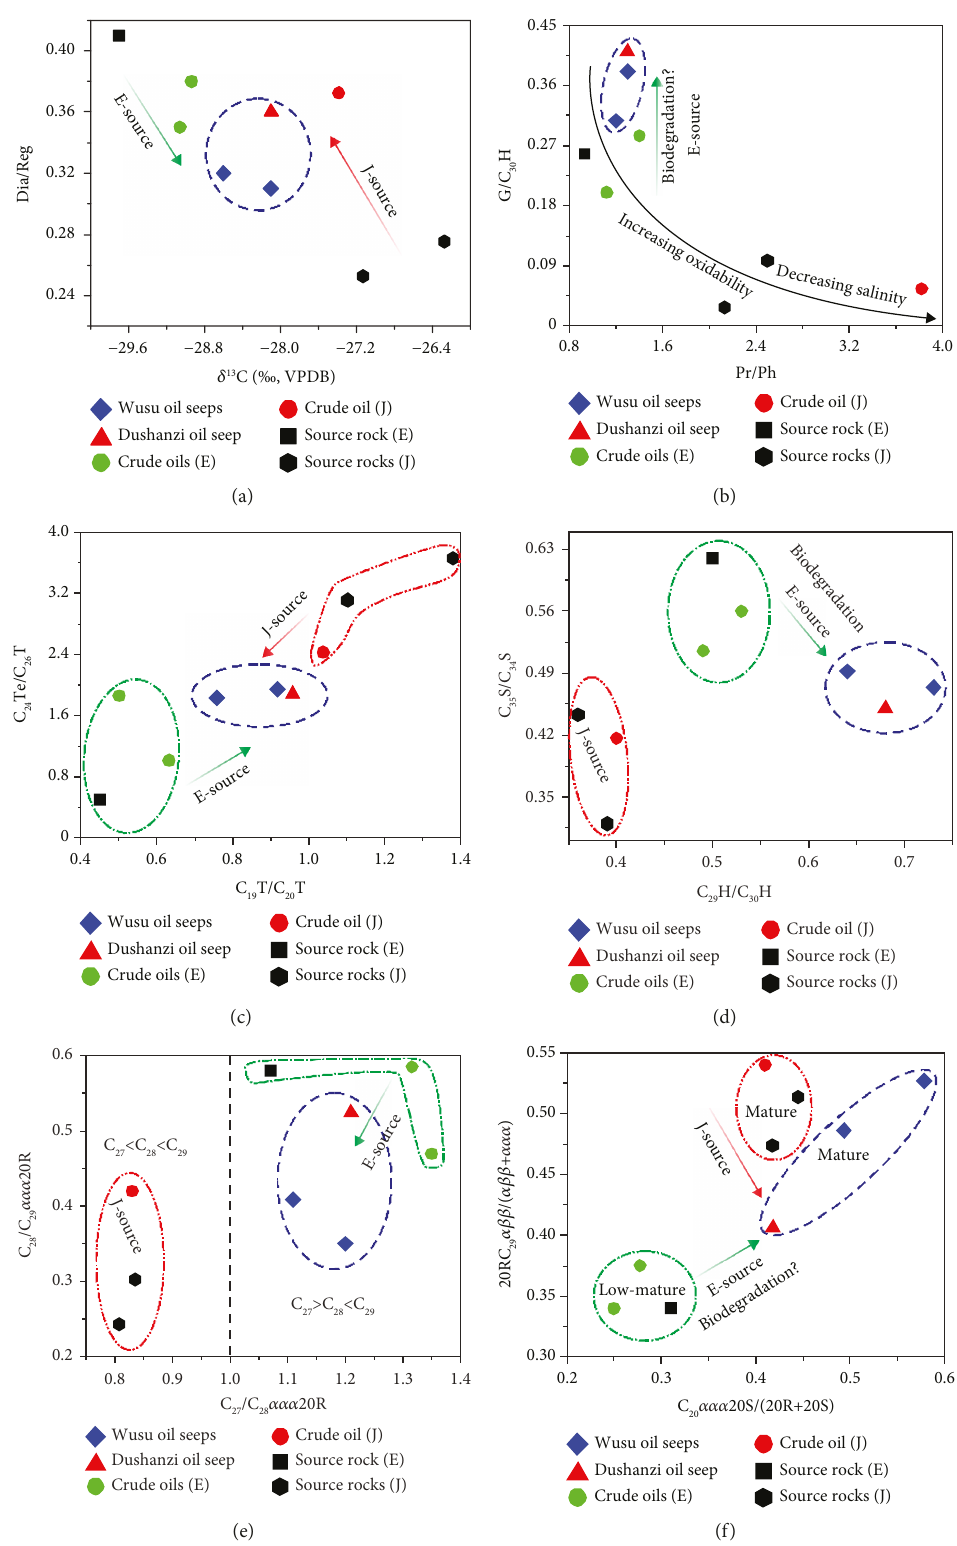
Figure 7: Plots of selected molecular geochemical parameters for oil-seep, crude-oil, and source-rock samples from the western segment of the southern Junggar Basin. (a) δ 13 C (in ‰ relative to the VPDB standard) vs. Dia/Reg; (b) Pr/Ph vs. G/C ααα 20R vs. C ααα 20R; (f) C H/C H vs. C S/C S; (e) C /C /C (d) C 29 30 35 34 27 28 28 29 abbreviations. Data from Table